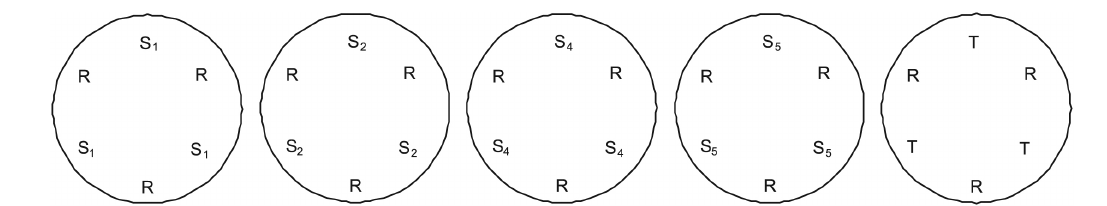
FIGURE 1 - 5 x 1 assay: five Petri dishes were used. The reference concentration (R) was tested concomitantly with all other concentrations. S (625.00 µg/mL), S (312.50 µg/mL), R (156.25 µg/mL), S 1 2 standard solutions. T represents the sample solution (156.25